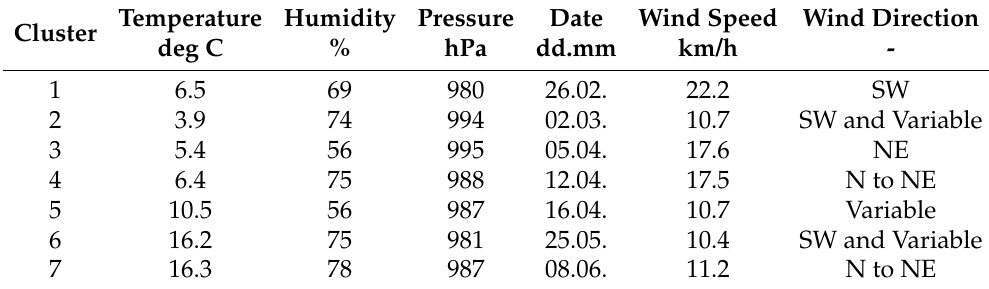
Figure 6. Dependence of k-means inertia on the number of clusters. Table 4. Centroid values of k-means clustering.